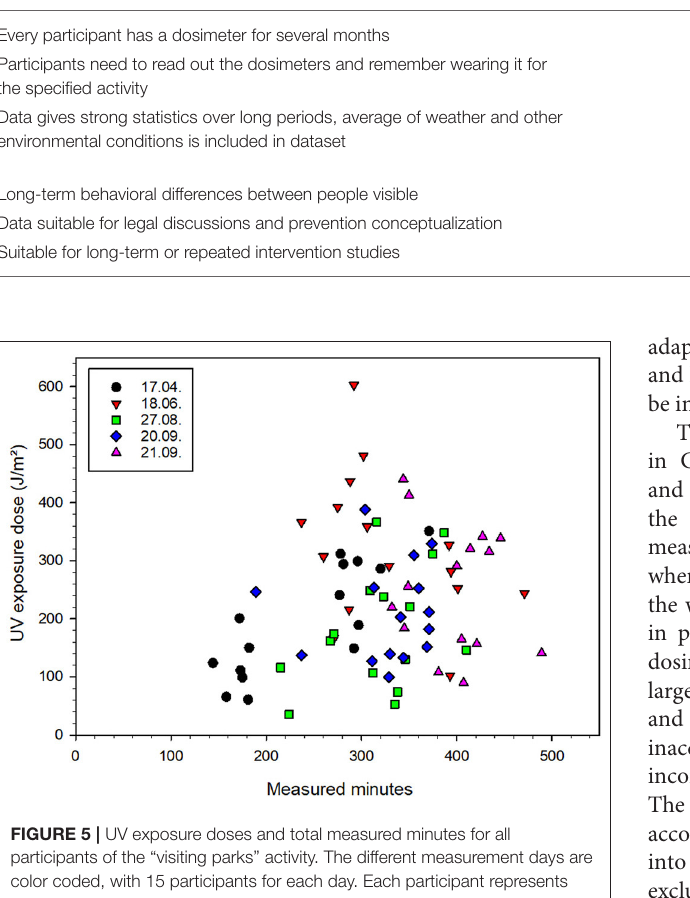
TABLE 3 | Comparison of both approaches for measuring personal UV exposure. Long period measurements